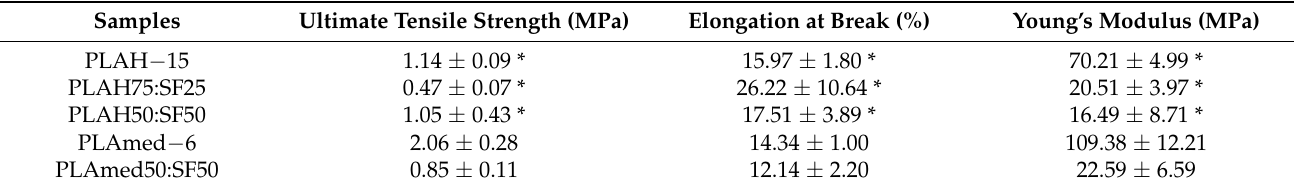
Table 5. Mechanical properties of PLA based scaffolds.